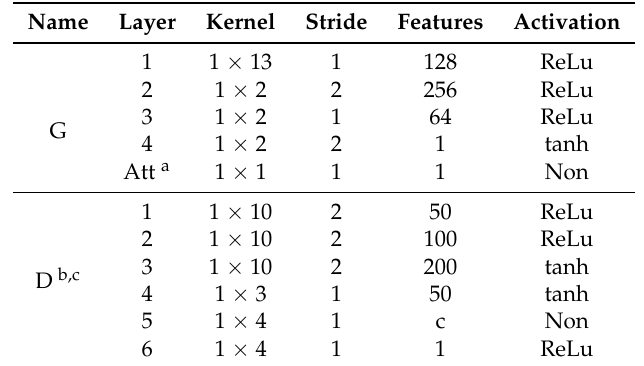
Table 1. Detailed configuration of SaGAAN.